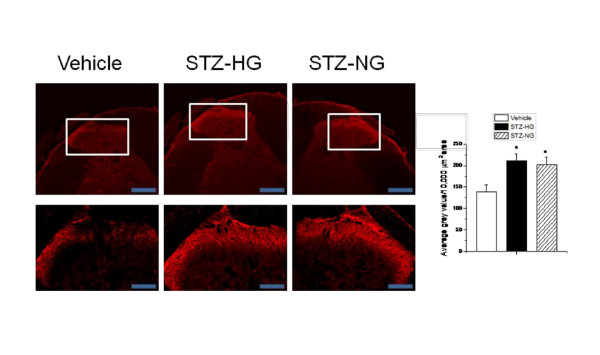
Altered TRPV1 staining in spinal cord dorsal horn of STZ-treated rats. A. Representative images of TRPV1 staining from a vehicle-treated, STZ-HG and STZ-NG rats. An enlarged segment has also been shown. B. Average gray values/10,000 μm2 area of TRPV1 staining in dorsal horn was significantly increased (p < 0.05) in both STZ-HG and STZ-NG rats as compared to vehicle-treated rats. Asterisk (*) represents p < 0.05. Scale bar is 200 μm and 50 μm for upper and lower panels, respectively.